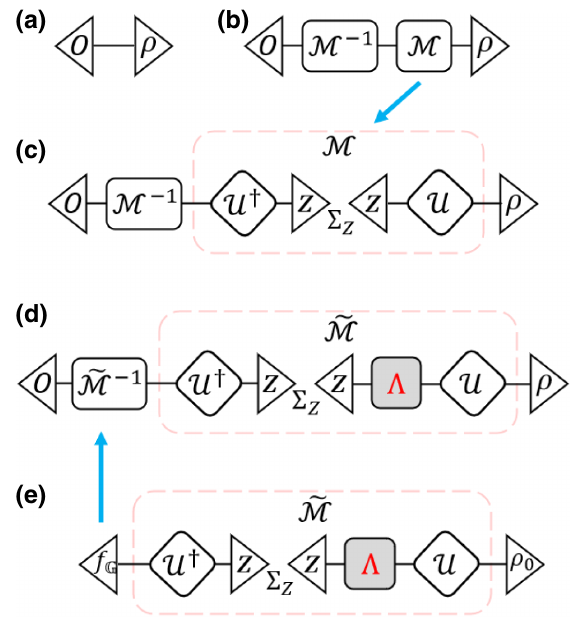
FIG. 1. Diagram of the shadow estimation protocol. (a) We want to estimate the expectation value Tr ( O ρ) = (cid:6)(cid:6) O | ρ (cid:2)(cid:2) for a set